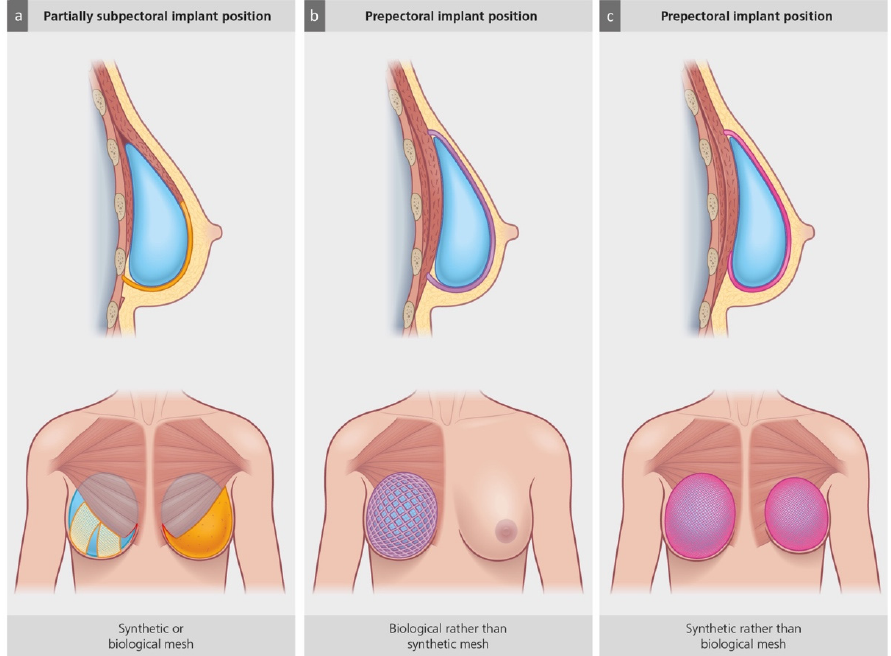
Figure 3. Schematic drawing of three different clinical situations during implant-based breast reconstruction (BR). ( a ) Subpectoral placement of an expander or implant requires the partial detachment of the greater pectoral muscle with partial medial disinsertion. Absence of fixation using synthetic mesh strips (right hemithorax) or biologic meshes (acellular dermal matrix; ADM; left hemithorax) will result in cranial muscle retraction. ( b ) Prepectoral expander or implant placement in patients with thin mastectomy flaps may benefit from thickened adipocutaneous implant coverage, due to ADM or synthetic meshes with tissue-integrative potential. ( c ) Prepectoral implant placement in patients with a mismatch between the large footprint of the breast after a mastectomy (e.g., breast hypertrophy) or a wide implant pocket in revisional breast surgery (e.g., down-sizing of breast implant volume) and implant size. When using a smaller implant, these patients may benefit from implant positioning and fixation using synthetic, pocket-shaped meshes rather than